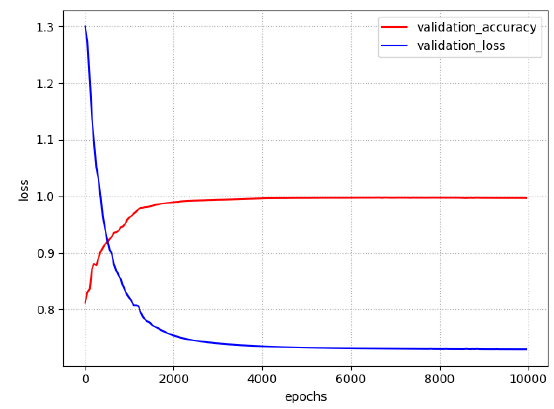
Figure 8. The loss and cross validation curves of the BP-ELMNN during training process.